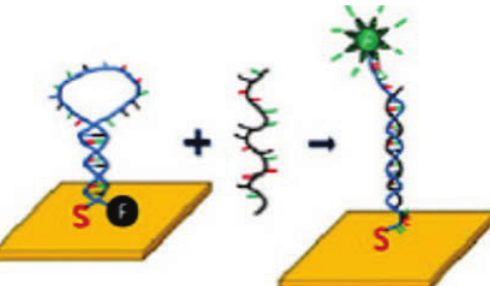
Figure 9. Schematic diagram of DNA hairpin immobilization and hybridization. Reprinted with permission from [55]. Copyright 2011 Elsevier [